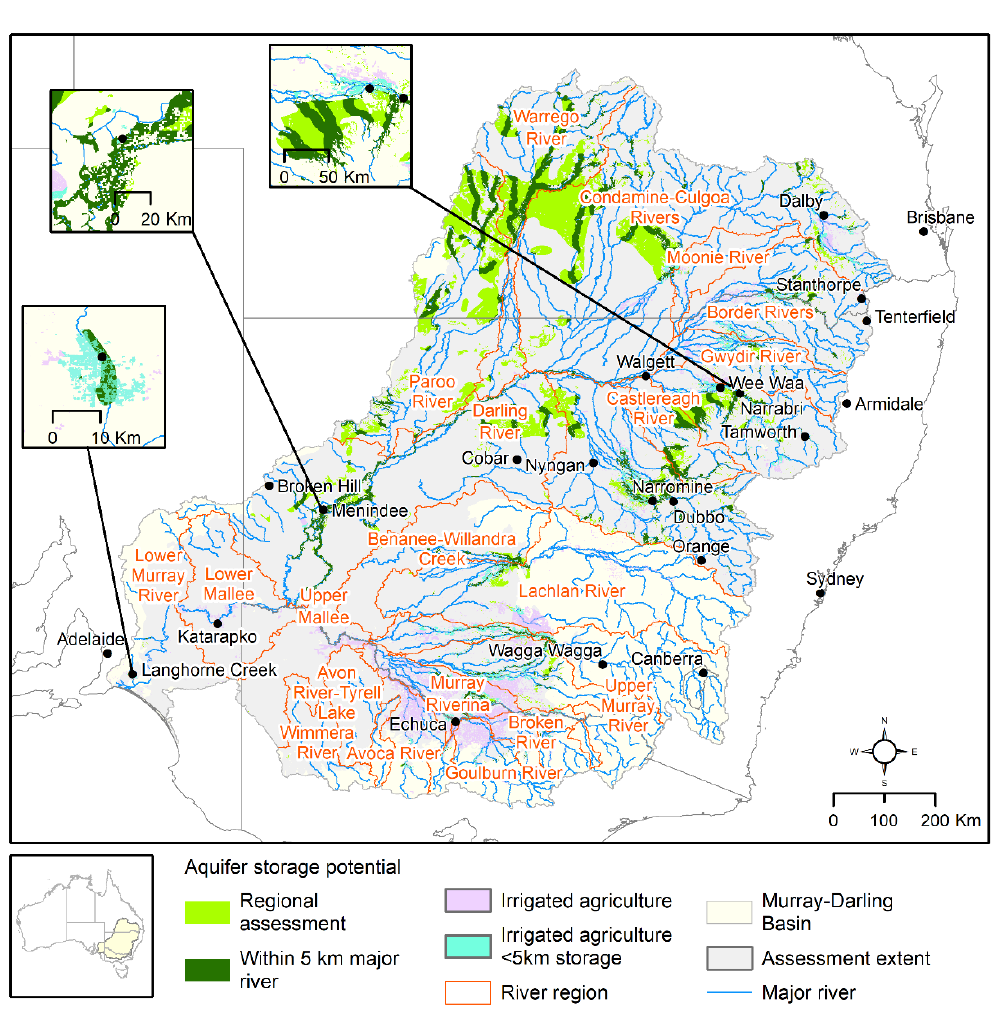
Figure 4. Murray–Darling Basin (MDB) regional aquifer storage potential in alluvium, colluvium, and sand plain aquifers where clay content < 40%, slope < 10%, regolith thickness > 10 m, water table depth > 5 m, and groundwater salinity < 3000 mg / L, and storage within 5 km of major watercourses, and irrigated agriculture within 5 km of storage.